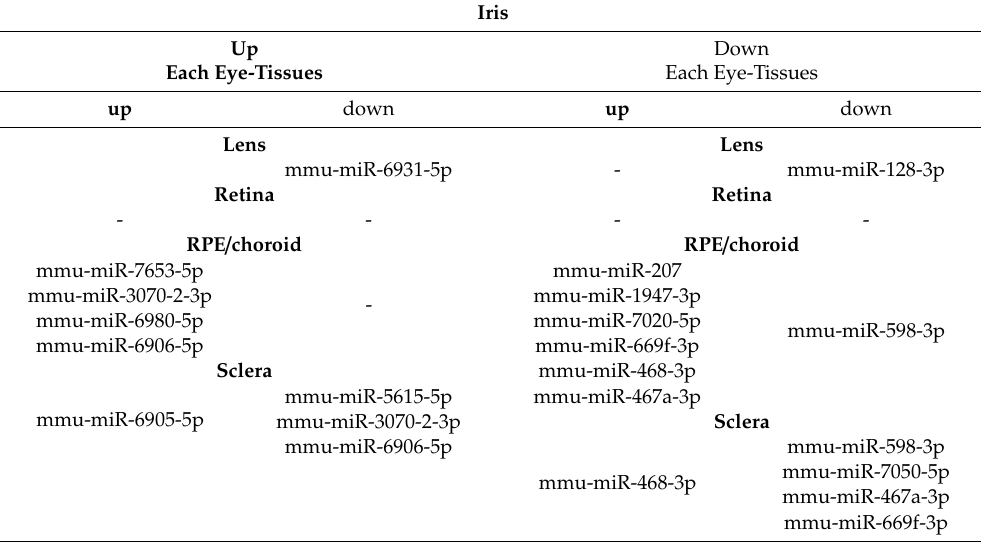
Table 3. Overlapping expression changes in miRNAs in iris and other ocular